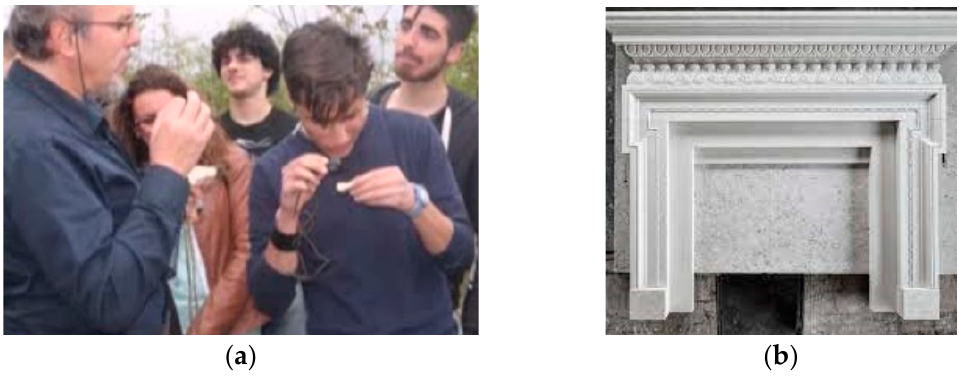
Figure 7. Two moments of the visit to a lapideous valuable georesources (year 2018): ( a ) palaeontological observations in a ‘Breccia irpina’ quarry in Fontanarosa (Avellino Province); ( b ) transformation of the quarried stone material into precious artistic